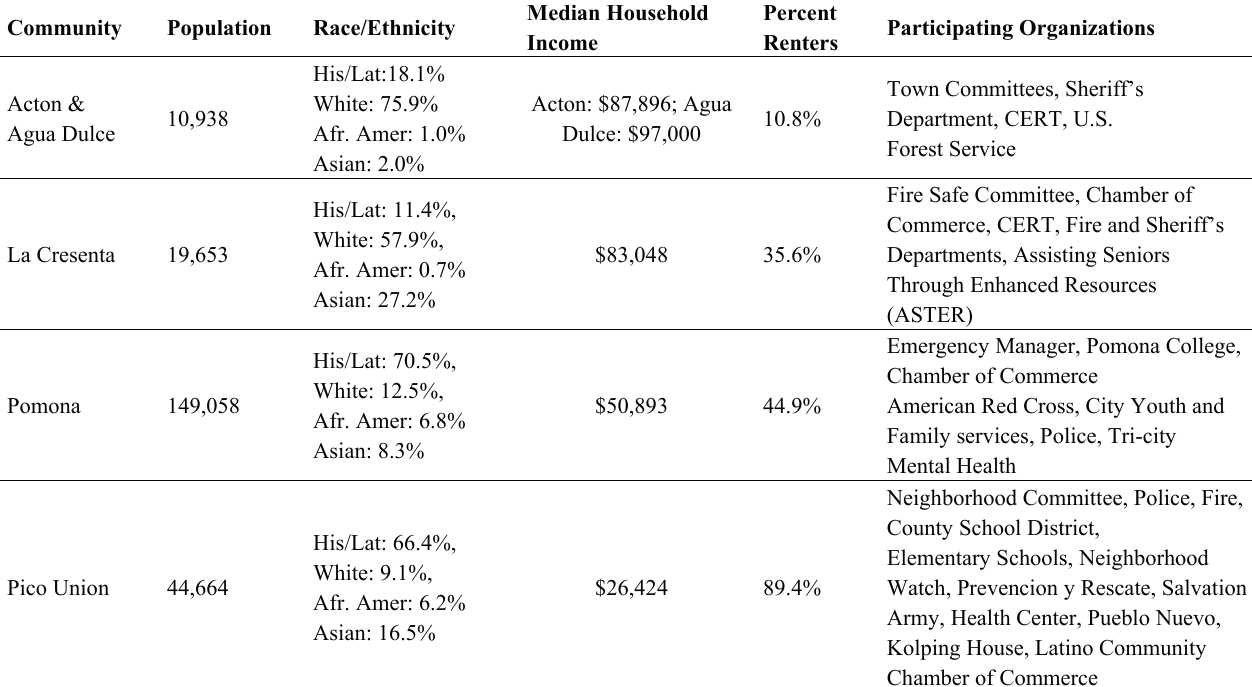
Table 1. Description of the Sixteen Communities and Coalitions in the Los Angeles County Community Disaster Resilience Project (LACCDR)